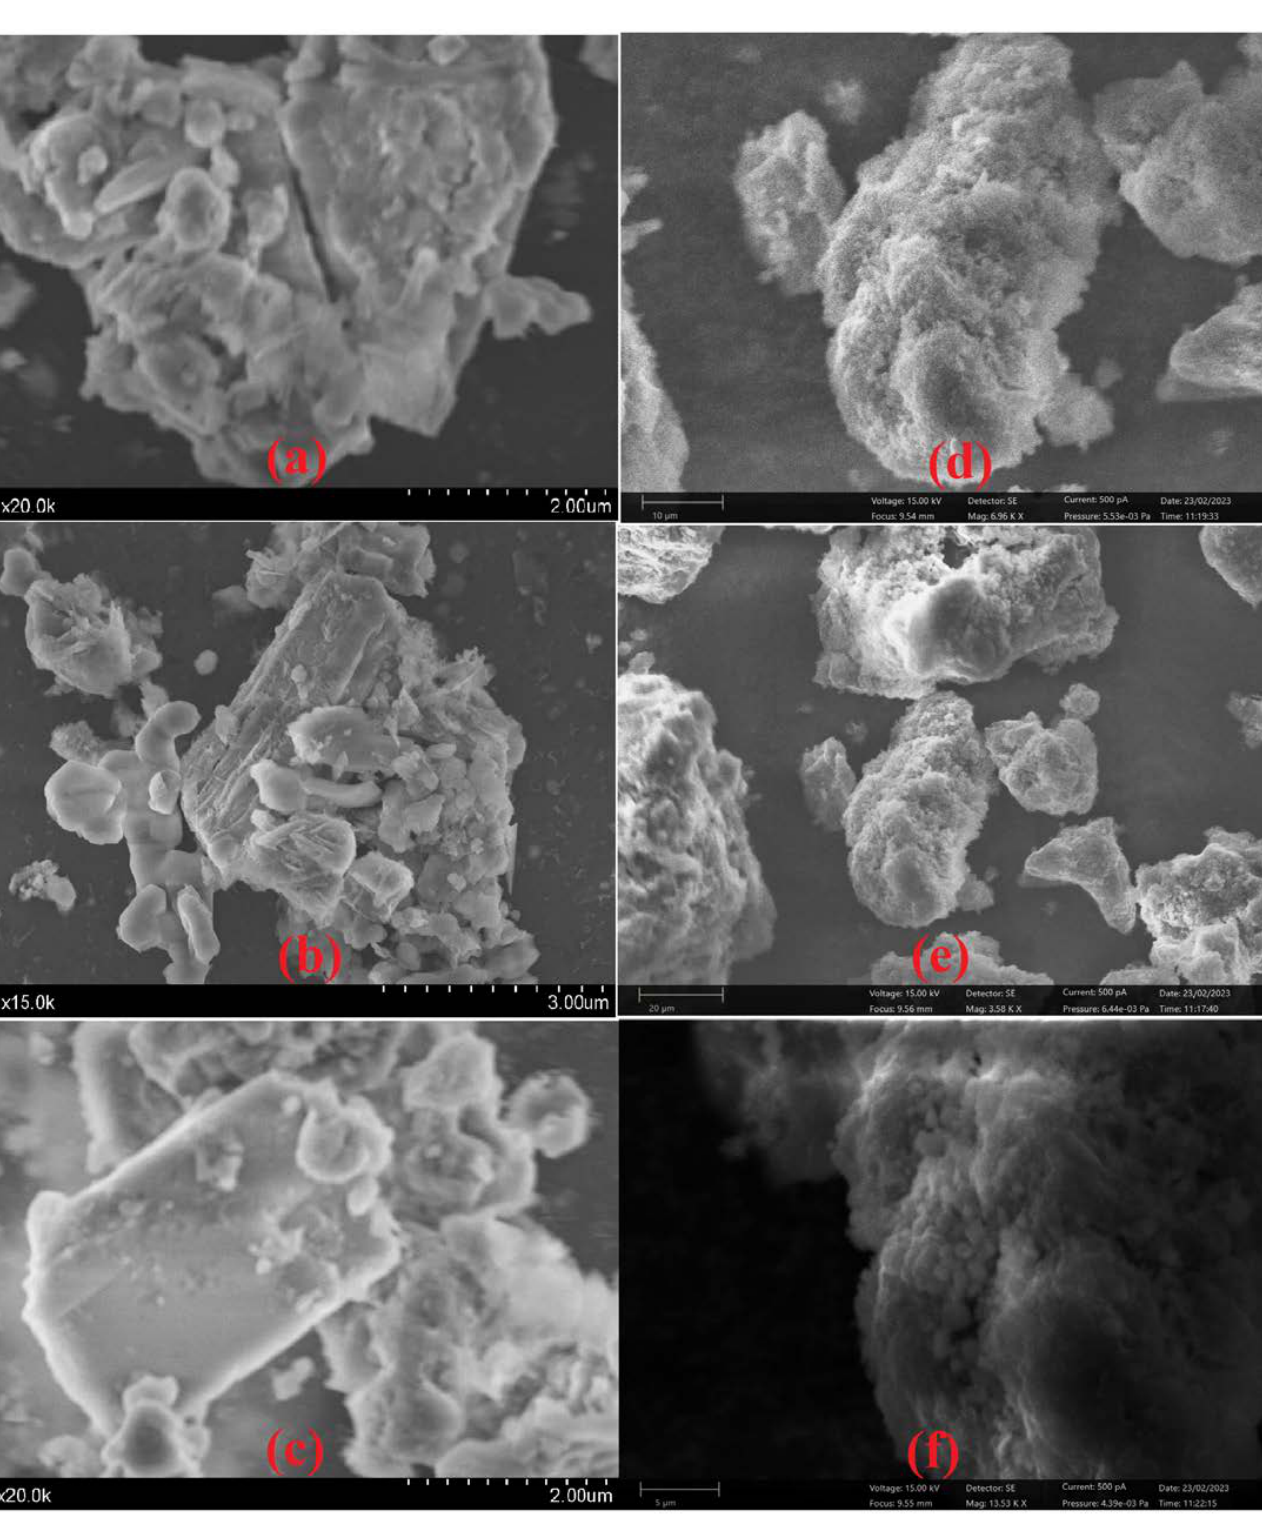
Figure 14. Scanning electron microscope (SEM) of SS before adsorption ( a – c ), and SS-loaded TA after adsorption ( d – f